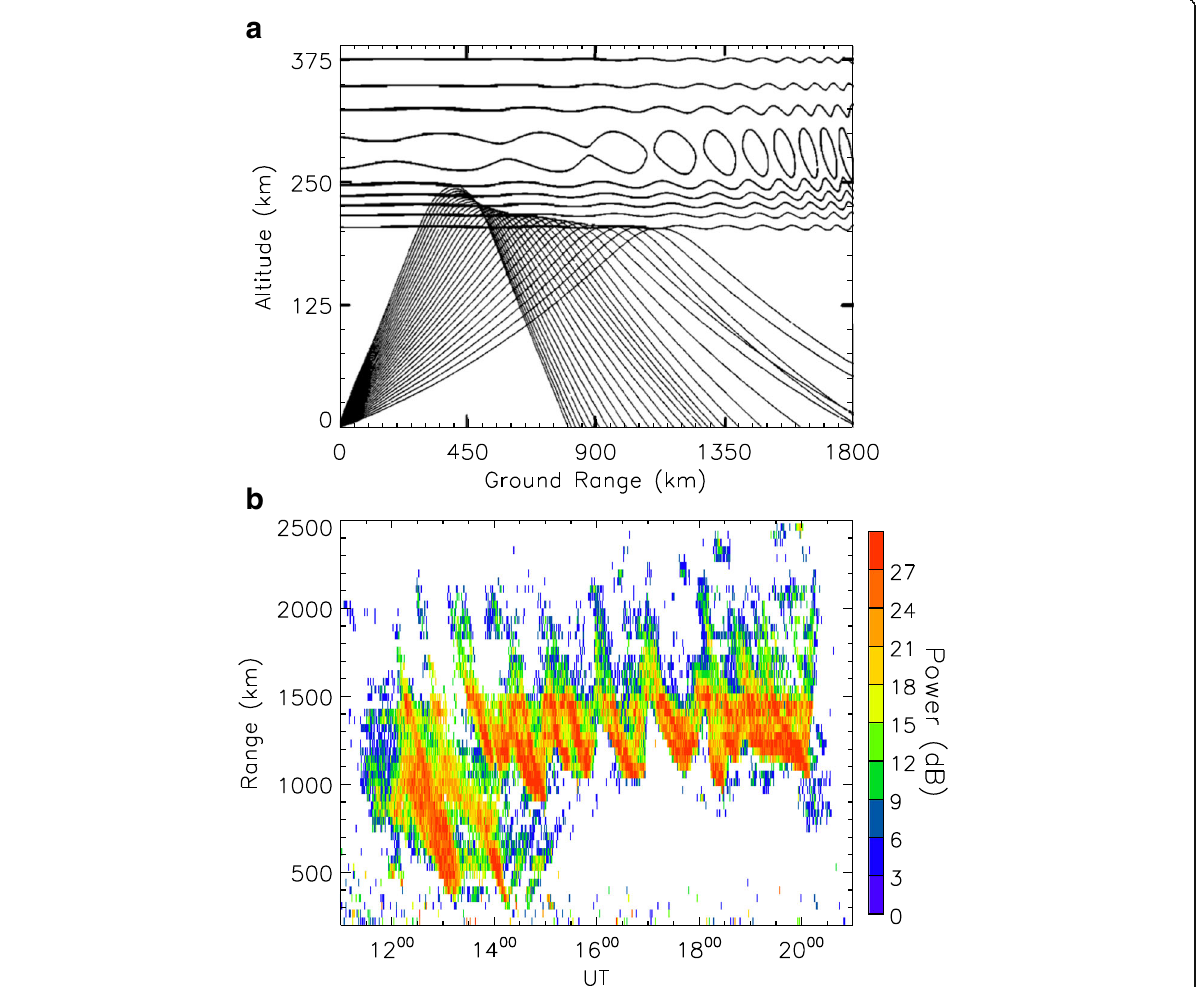
Fig. 27 a Model ray paths of HF radar propagation through an ionosphere modulated by a TID. Focusing and defocusing at the ground is caused by the uneven contours of electron density (adapted from Samson et al. (1990)). b Example of FIR radar ground scatter data received along a single beam, versus ground range and universal time, showing several signatures of TID moving toward the radar. Reproduced from Fig. 2 of Grocott et al.